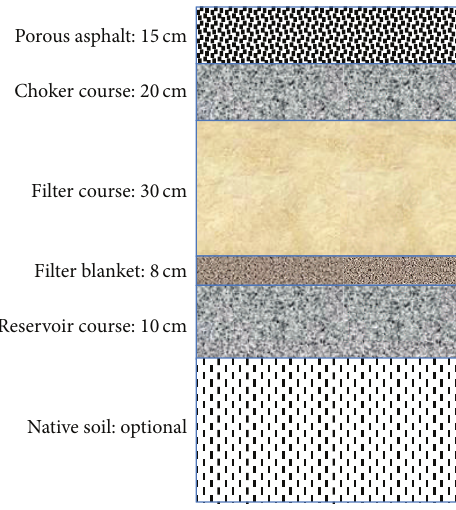
Figure 1: Typical cross-section for pervious pavement